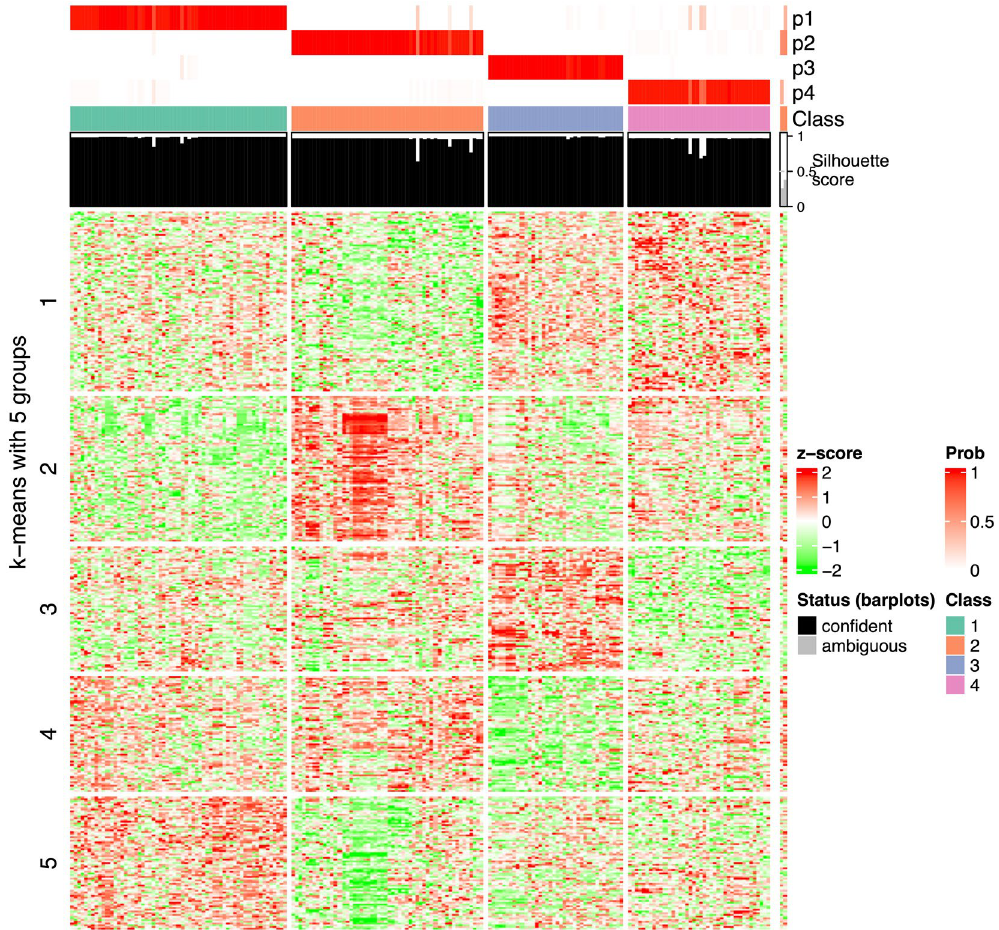
Figure 5. Heatmap of the signature genes and their regulation in each class. 9368 signature genes (58.1% of total genes) chosen for an FDR < 0.01. This heat map represents the differences in expression relative to the average FC for each gene. Table 3. Summarizes these